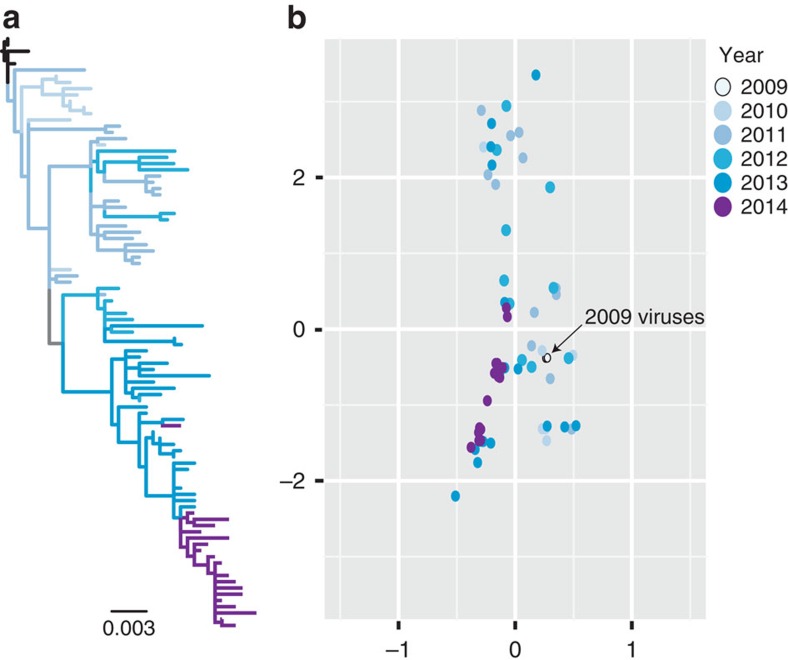
Antigenic evolution of human H1N1/2009 viruses.(a) Maximum likelihood phylogeny of the HA gene of Australian viruses used in the HI assay. Coloured branches represent the year of virus isolation on the right. Scale bar represents number of substitutions per site. (b) Antigenic cartography of H1N1/2009 viruses reconstructed based on HI assays of pandemic and post-pandemic strains against a panel of polyclonal antisera. Coloured dots correspond to the year of virus isolation. The position of viruses isolated in 2009 is indicated by the black arrow.